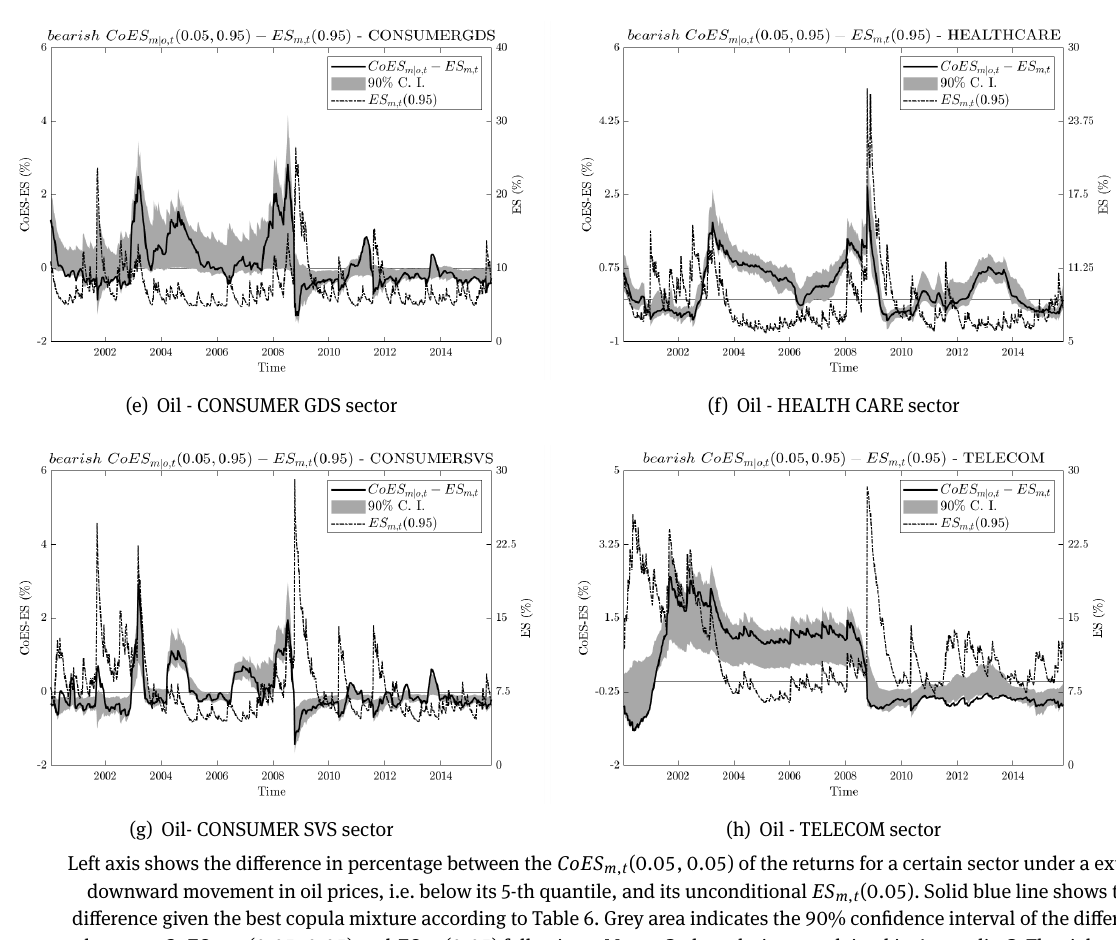
Figure 19b: CoES m | o , t (0.05, 0.05) for a certain sector given a bearish scenario for oil